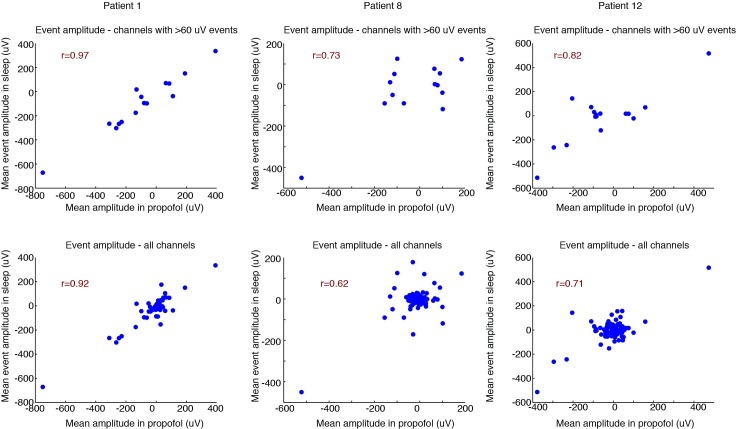
Correlated spatial properties of events across emergence and sleep.Top row: correlation for each patient of the mean event amplitude across electrodes in emergence vs. sleep. This analysis includes only channels where the mean event in the propofol condition was > 60 µV, indicating channels that exhibited a robust LP. Consistent correlations demonstrate that the spatial distribution of LPs in emergence is very similar to KCs during sleep. In this context, channels with large values are channels with large LP signals (rather than noisy or outliers). 95% confidence intervals from bootstrap are significant in 2/3 subjects; Pearson’s test significant in 3/3 subjects (95% bootstrap CIs: [0.87 1], [−0.26 0.94], [0.25 0.95]; 95% Pearson CIs: [0.90 0.99], [0.33 0.91], [0.56 0.94]). Bottom row: same analysis, including all channels. 95% confidence intervals from bootstrap are significant in 2/3 subjects; Pearson’s test significant in 3/3 subjects (95% bootstrap CIs: [0.74 0.97], [−0.15 0.87], [0.15 0.88]; 95% Pearson CIs: [0.88 0.95], [0.47 0.74], [0.60 0.79]). Central cloud demonstrates channels with no LP. These channels also tend to exhibit no KCs (near-zero value on y-axis), demonstrating that channels without LPs also tend to be channels without KCs.